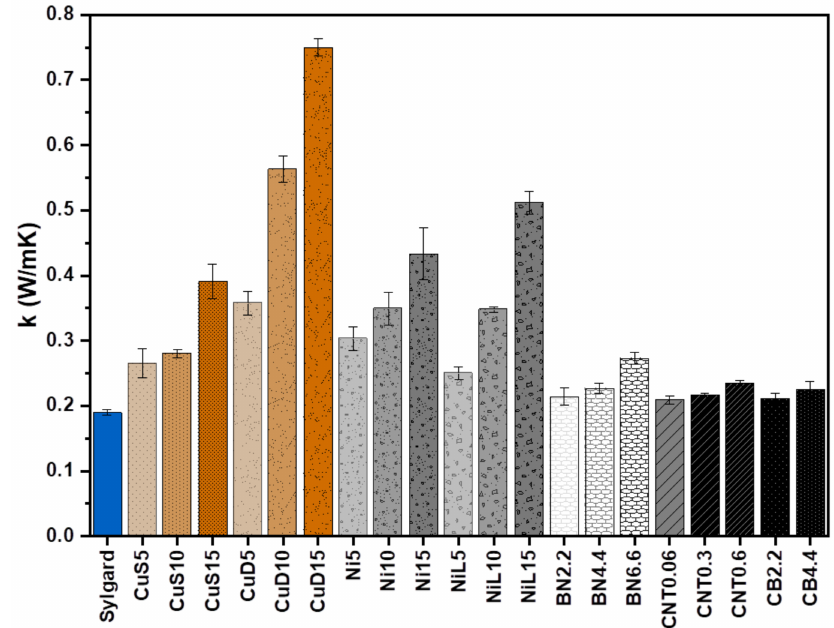
Figure 7. k values of the different composite measured by Hot Disk.